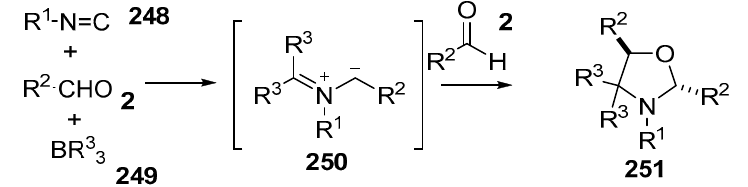
Scheme 73. Cycloaddition of azomethine ylides, generated by the reaction of aldehydes 2 , isocyanides 248 and organoboron compounds 249 .